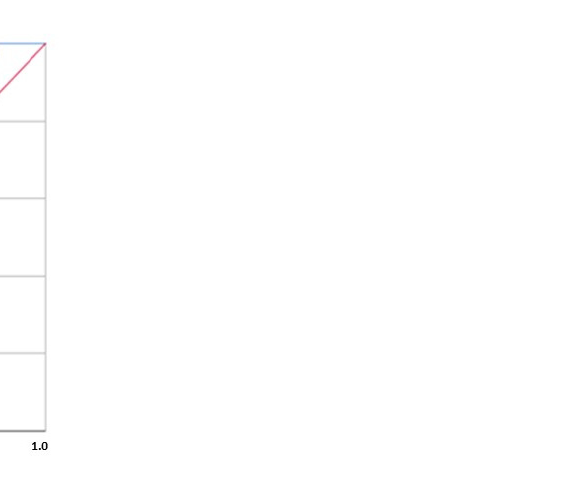
Figure 4. Correlation between fecal calprotectin levels and lesions at magnetic resonance enterogra- phy (MaRIA Index).